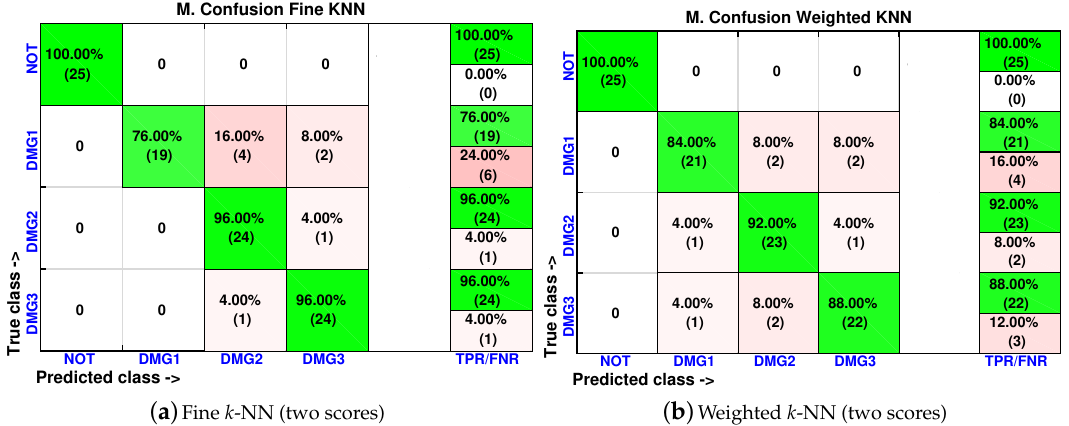
Figure 32. Confusion matrix using fine k -NN ( a ) and weighted k -NN ( b ) when the feature vector is formed by the first two principal components.